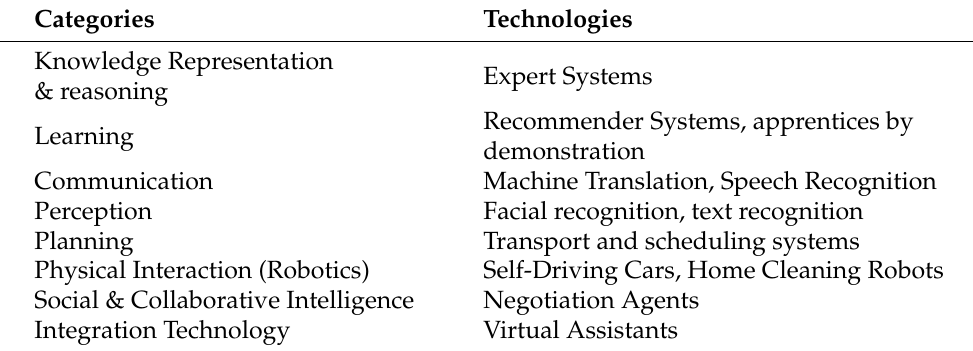
Table 2. AI-Categories with corresponding